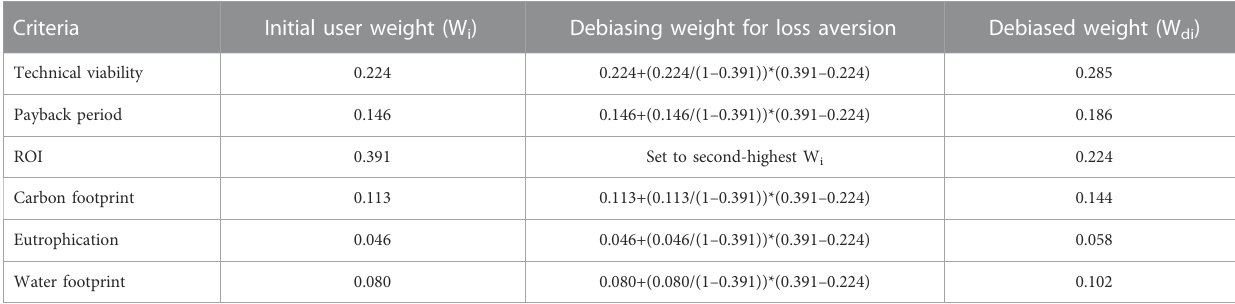
TABLE 3 Debiasing the initial user weights for the identi fi ed loss aversion bias from the cognitive map of Company A.